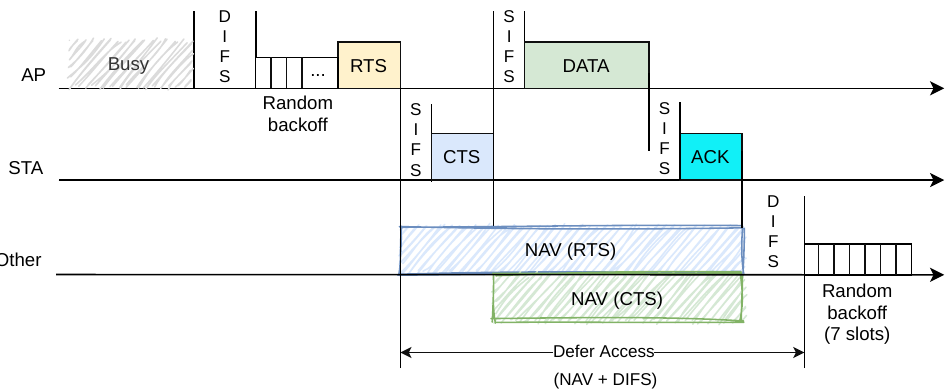
Figure 6. Channel access using the Distributed Coordination Function (DCF) in